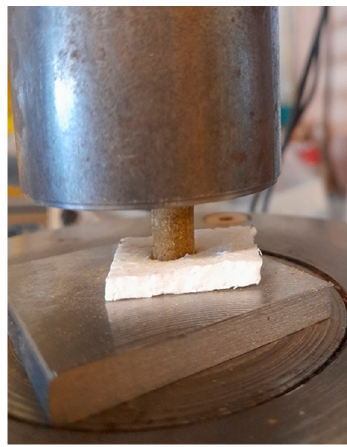
Figure 3. The sample in the compression test.